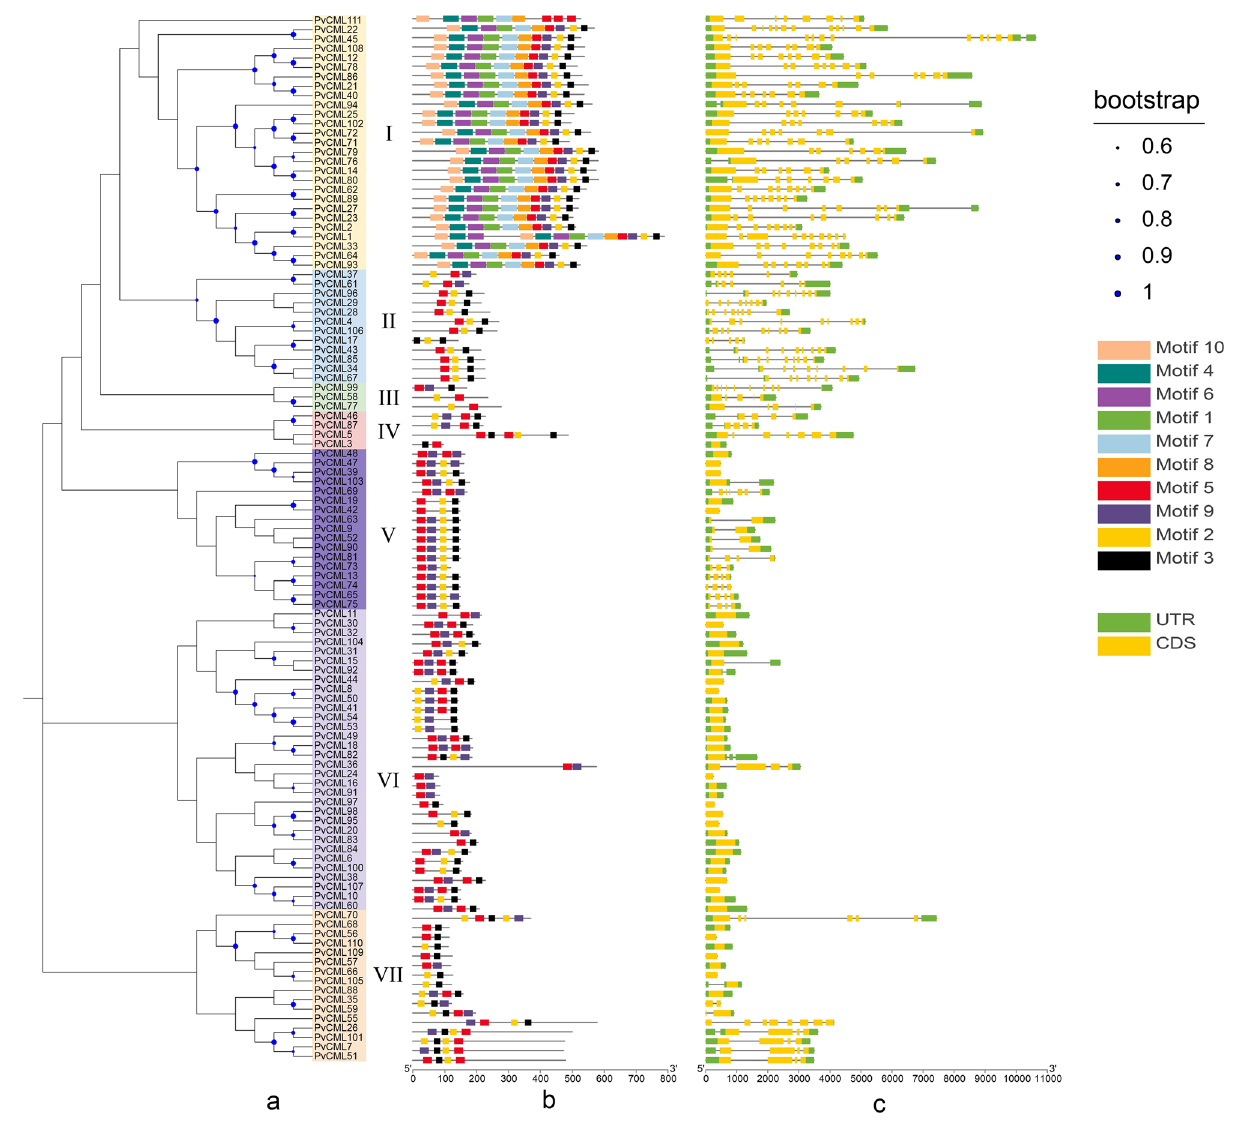
Figure 2. Phylogenetic relationships, gene structure, and motif compositions of PvCML genes. ( a ) Phylogenetic tree of PvCMLs . The phylogenetic tree was constructed with the maximum-likelihood method of MEGA X (1000 bootstrap replicates). The size of the blue circle represented bootstrap value. ( b ) Motif structure of PvCMLs . Different motifs were represented by different colors. Motif lengths were presented proportionally. ( c ) The gene structure of PvCMLs . The yellow box represented exon, and the green box represented the untranslated region. Intron represents by solid